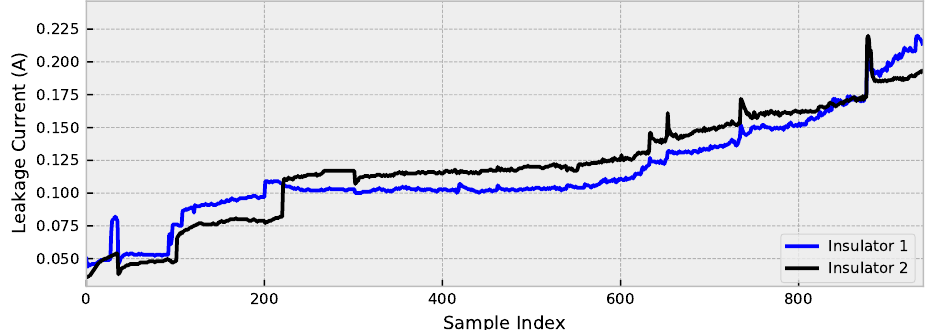
Figure 3. Leakage current of the evaluated